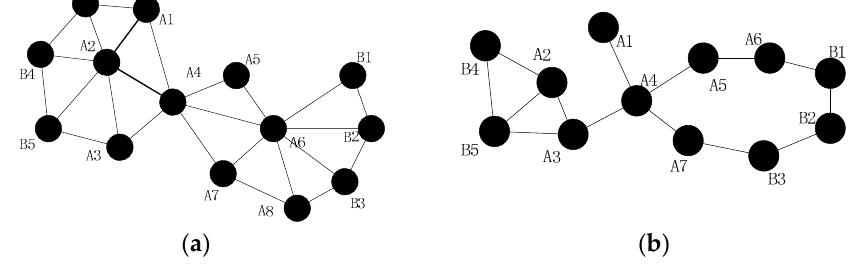
Figure 1. ( a ) Cut-vertex failure; and ( b ) normal node failure.